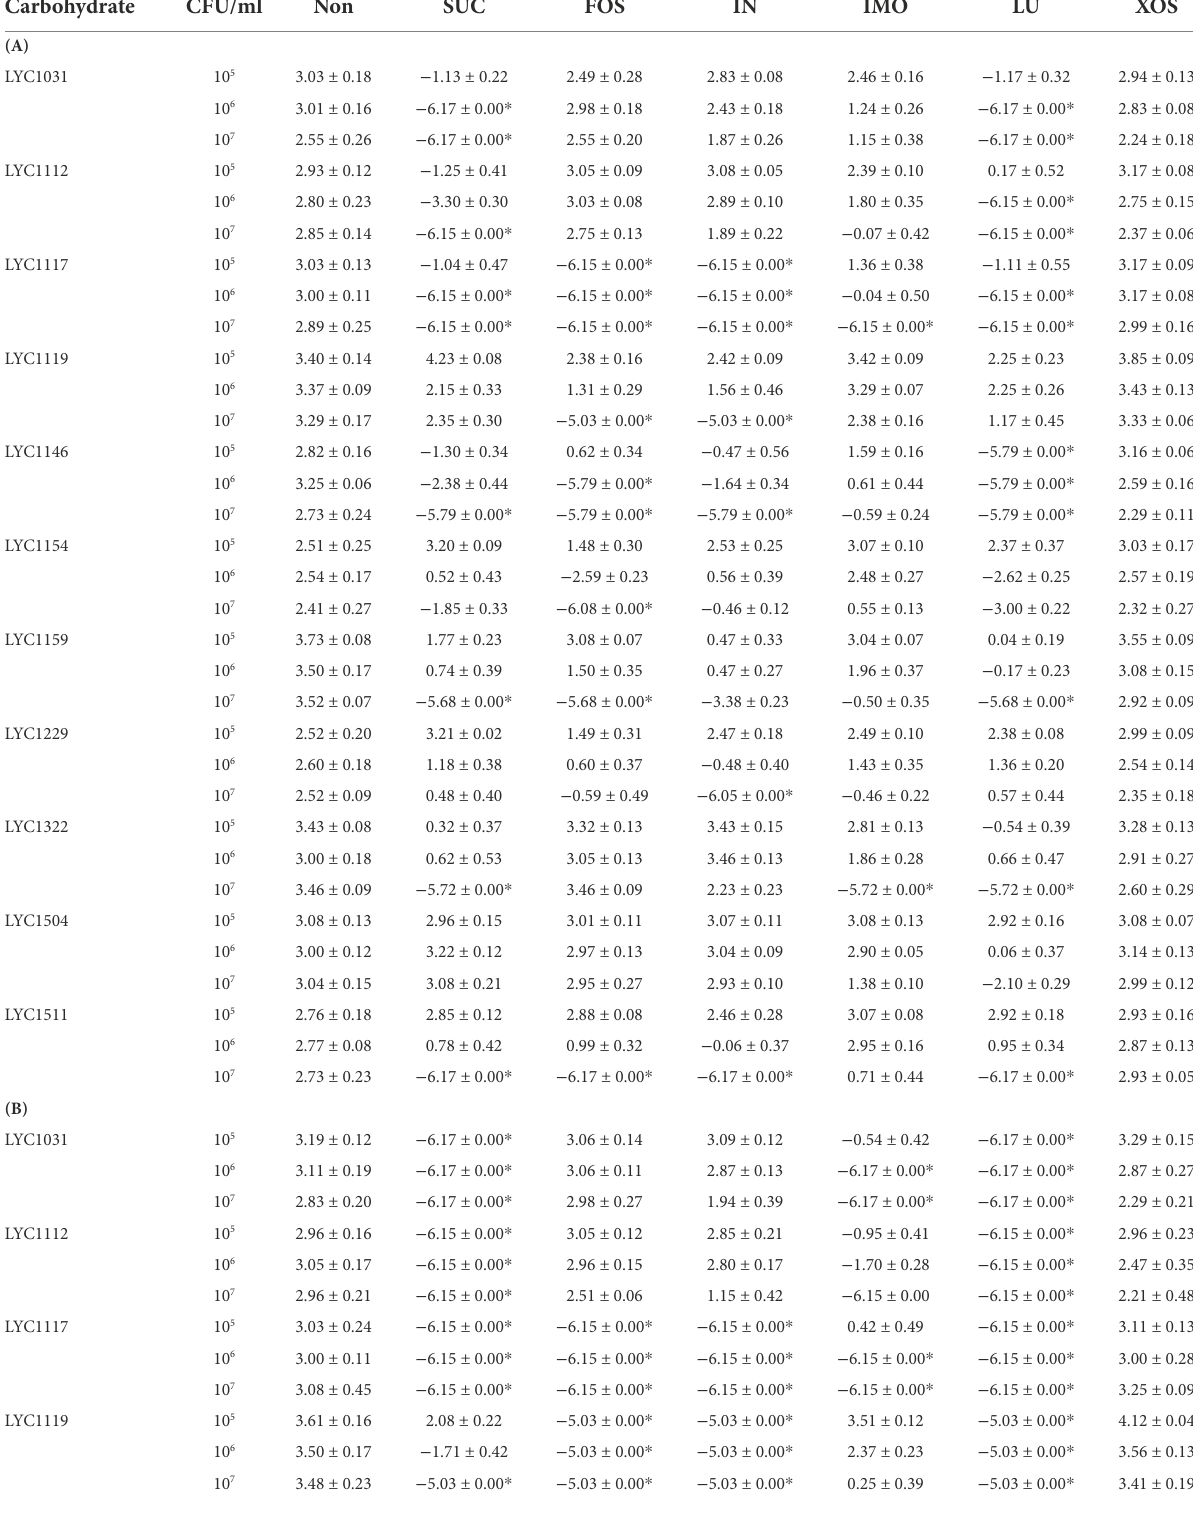
TABLE 3 The change in log10 CFU/ml of KPC001 cocultured with Lactobacillus strains in MRS-MH broth with different carbohydrates at 24 (A) and 48 (B) hours.